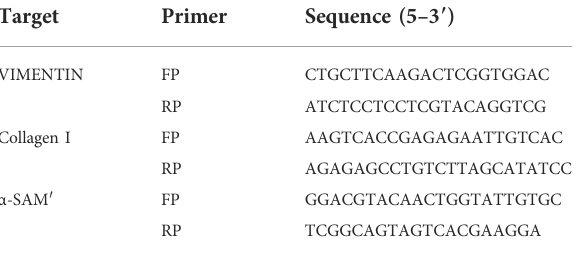
TABLE 3 List of primers for Real-time